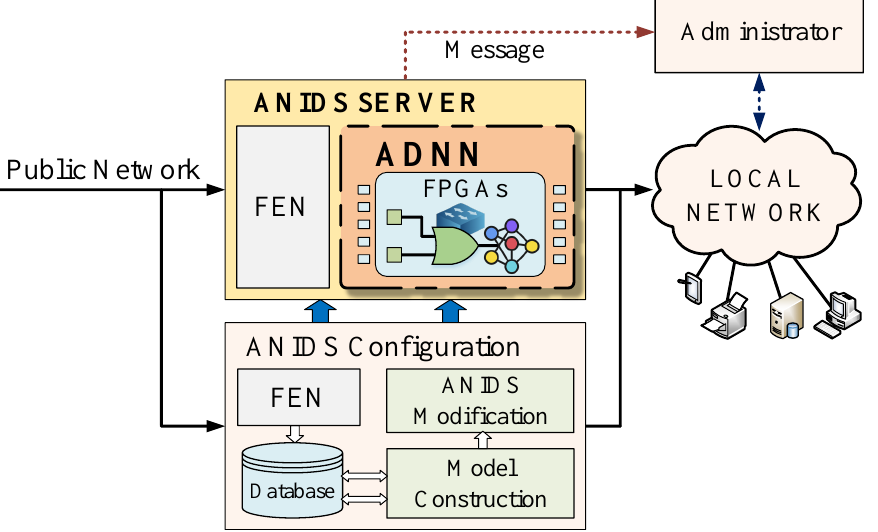
Figure 2. Overview of the proposed NIDS architecture.